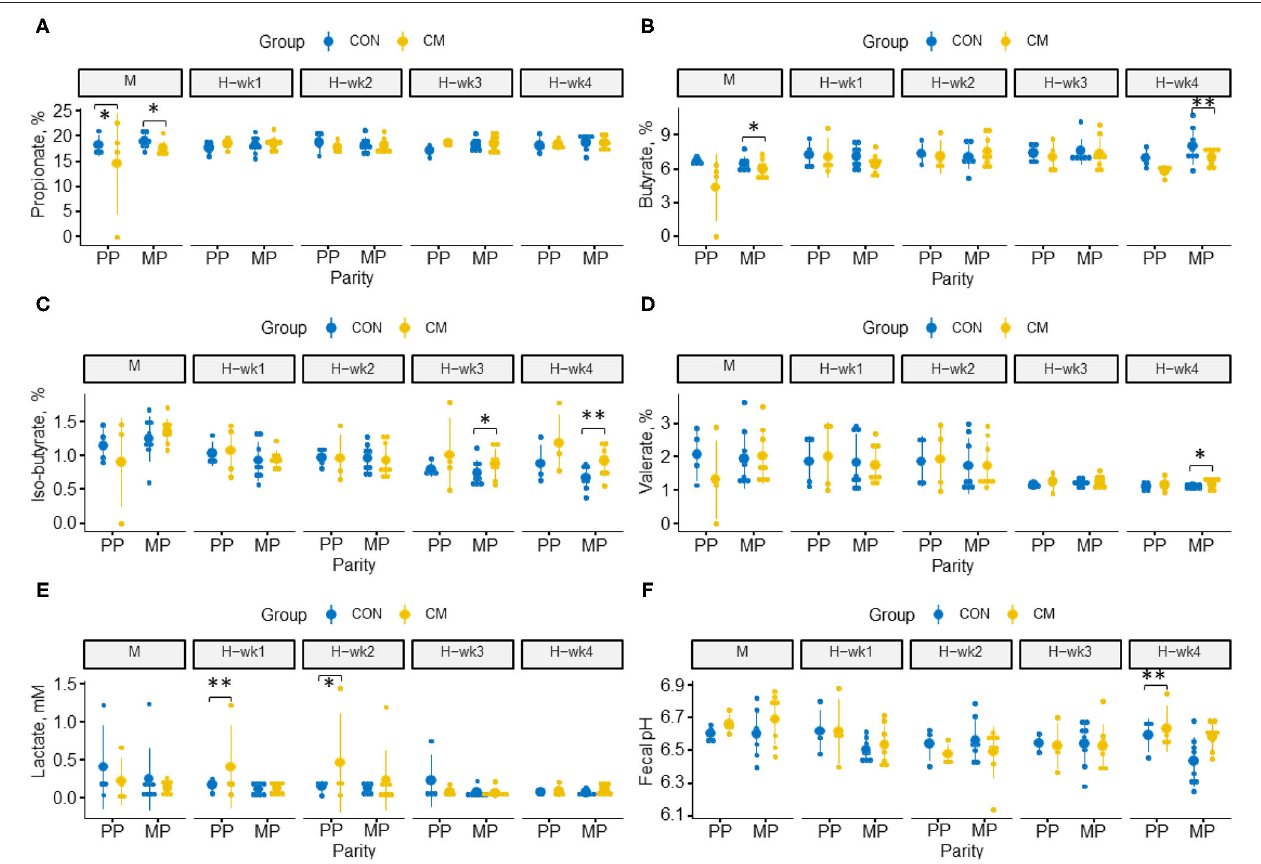
FIGURE 1 | Effects of clay mineral (CM) × parity interaction on hindgut milieu parameters during moderate-grain feeding (M), followed by 4 weeks of high-grain feeding (H-wk1 to H-wk4). Dot plots illustrate fecal concentrations of (A) propionate, (B) butyrate, (C) isobutyrate, (D) valerate, (E) lactate, and (F) fecal pH. Control (CON) and treatment (CM) samples are show in blue and yellow, respectively. (*) indicates a difference by trend within parities (0.05 < p ≤ 0.10), and (**) indicates significant differences within parities ( p ≤